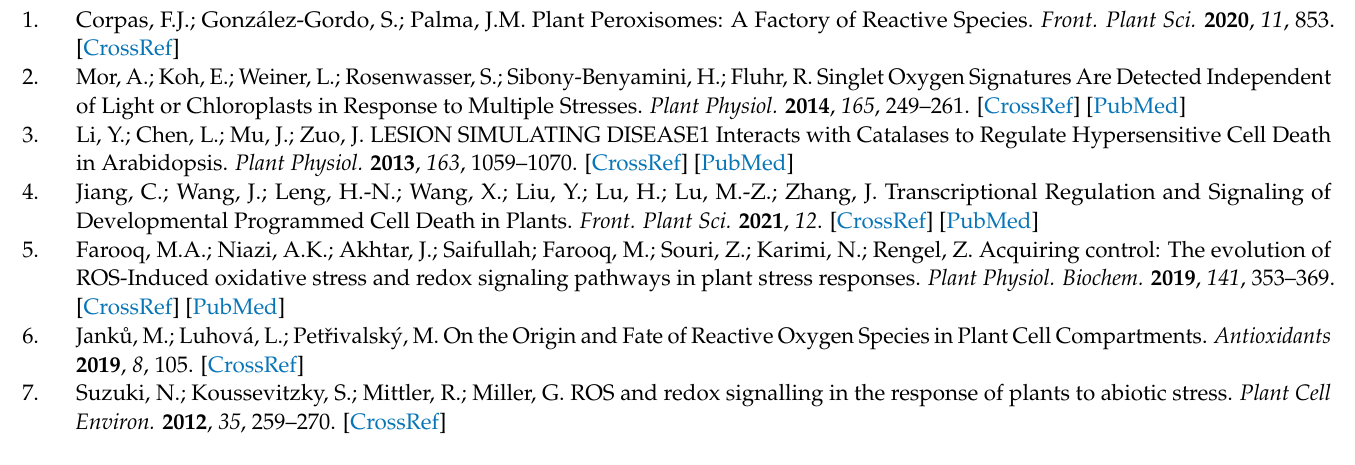
Gene ID Dicotyledon Monocotyledon ( Oryza sativa ) Arabidopsis